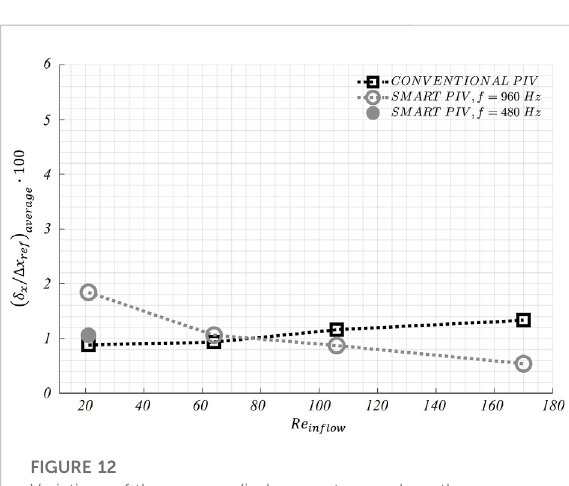
FIGURE 12 Variations of the average displacement error along the streamwise direction ( δ x ) normalized by maximum streamwise particle displacement ( Δ x ref ) as a function of the in fl ow Reynolds number( Re inflow )inthestenosedLADphantom.Forsmart-PIV, thenormalizedaveragedisplacementerror δ x / Δ x ref isevaluatedalso by virtually reducing the image acquisition frequency to 480 Hz (for Re inflow =